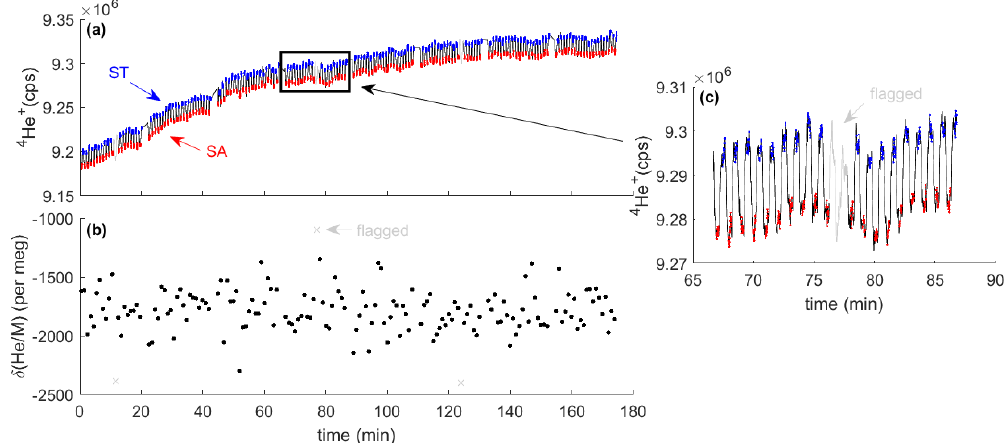
Figure 3. Typical analysis results from the measurement of two high-pressure cylinders. The MS monitors the 4 He + ion beam during switching between sample (SA) and standard (ST) gas (a) . Red and blue shaded data points highlight the periods used for integration and calculation of the delta value (b) . They are separated by idle times (black lines) to allow complete flush-out after switching. Data are quality controlled and flagged periods are shown in gray. Inset (c) shows one block of 20 sample–standard comparisons, including one pair of cycles that was flagged as an